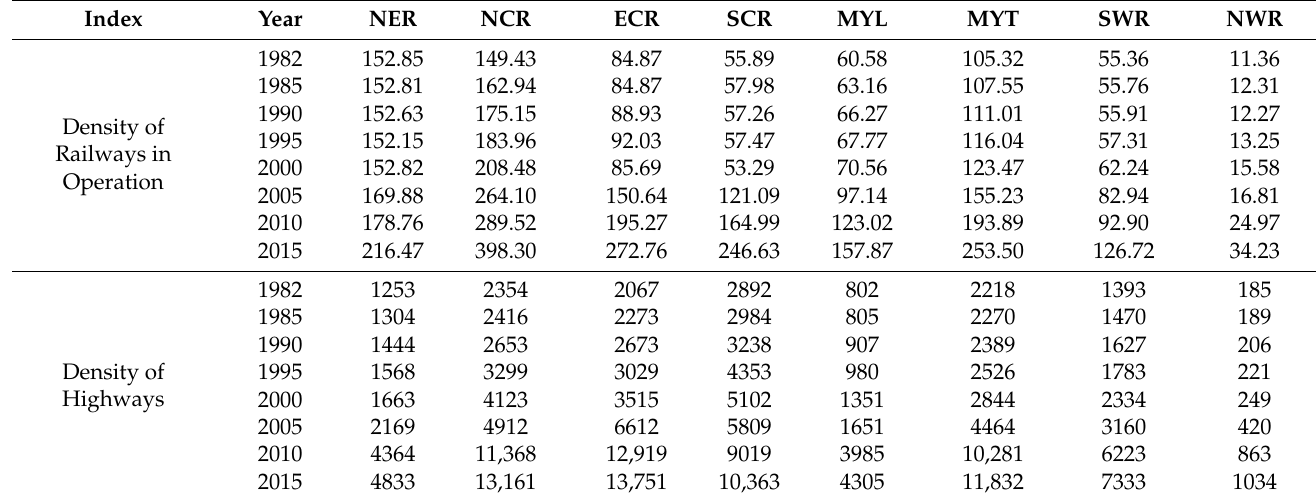
Table 3. Regional TI density in